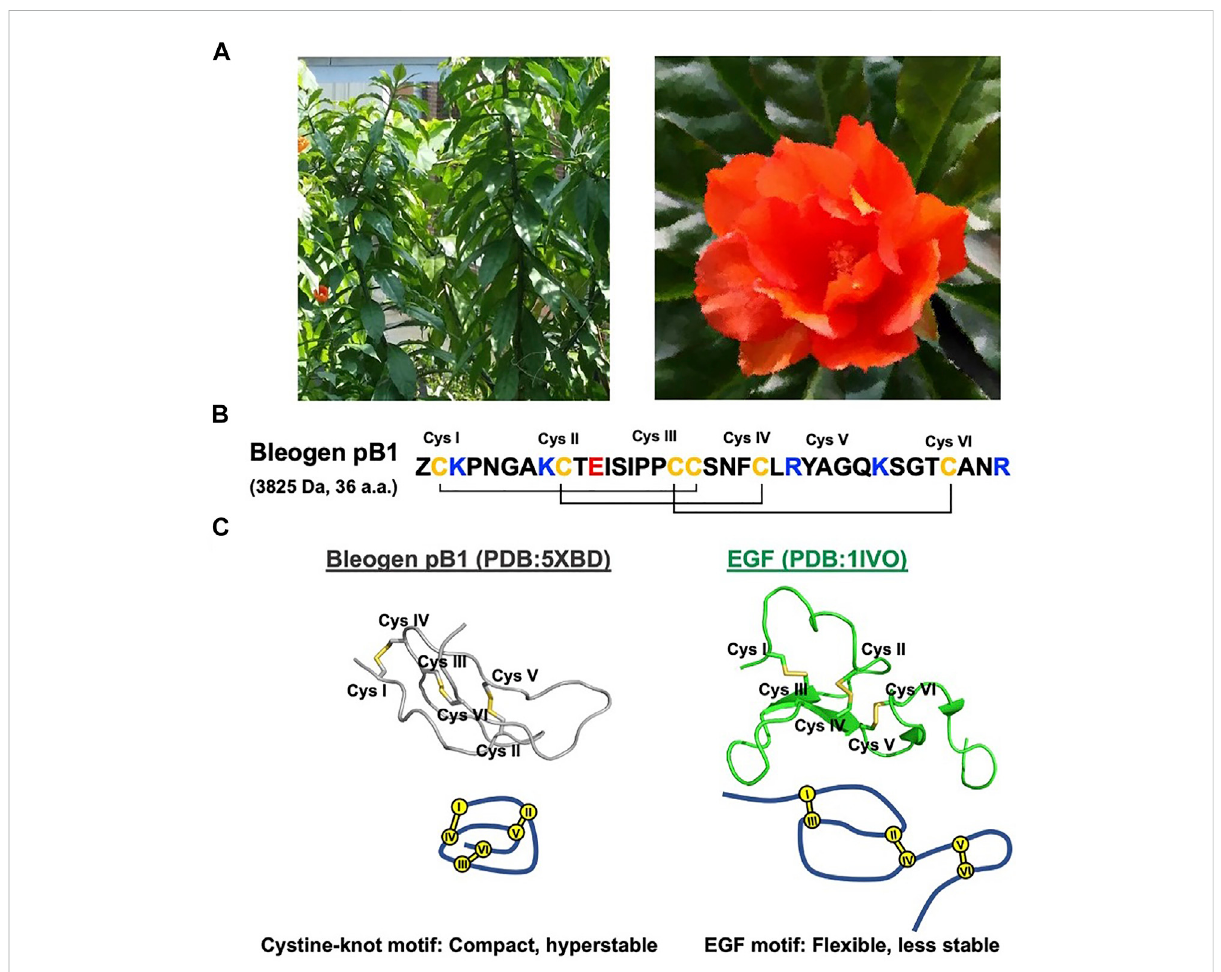
FIGURE 1 Bleogen pB1 is a cystine knot peptide deriving from Pereskia bleo and characterized by epidermal growth factor (EGF)-like activities. (A) Leaves and fl owers of Pereskia bleo . (B) Primary sequence of bleogen pB1, in which “ Z ” represents pyroglutamate. (C) Disul fi de connectivity and tertiary structural differences between bleogen pB1 and